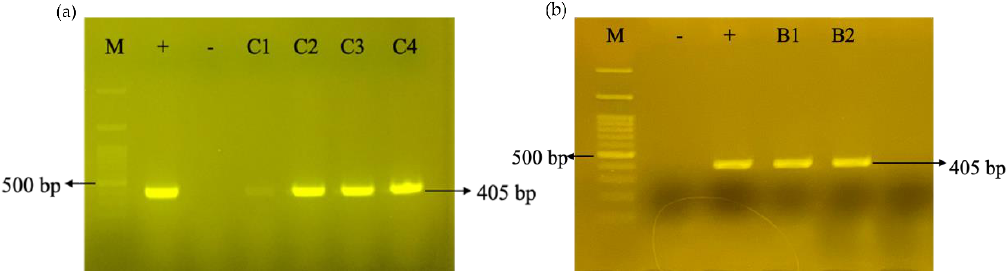
Figure 3. Representative gel electrophoresis image of PCR verification on the short fragment between gRNA entry vector (pGGA3) and the plant expression vector (pUMDC32-Ubi1) in ( a ) CRISPRi vector, pCTN, and ( b ) Agrobacterium tumefaciens strain LBA4404 harbouring pCTN. Lane M, 100 bp DNA ladder H3 RTU (GeneDireX, Taiwan, China); Lane -, PCR negative control using double- distilled water as DNA template; Lane +, PCR positive control using plasmid pCTN; Lanes C1 – C4, Escherichia coli transformed with pCTN; Lanes B1 and B2, A. tumafaciens transformed with plasmid pCTN.